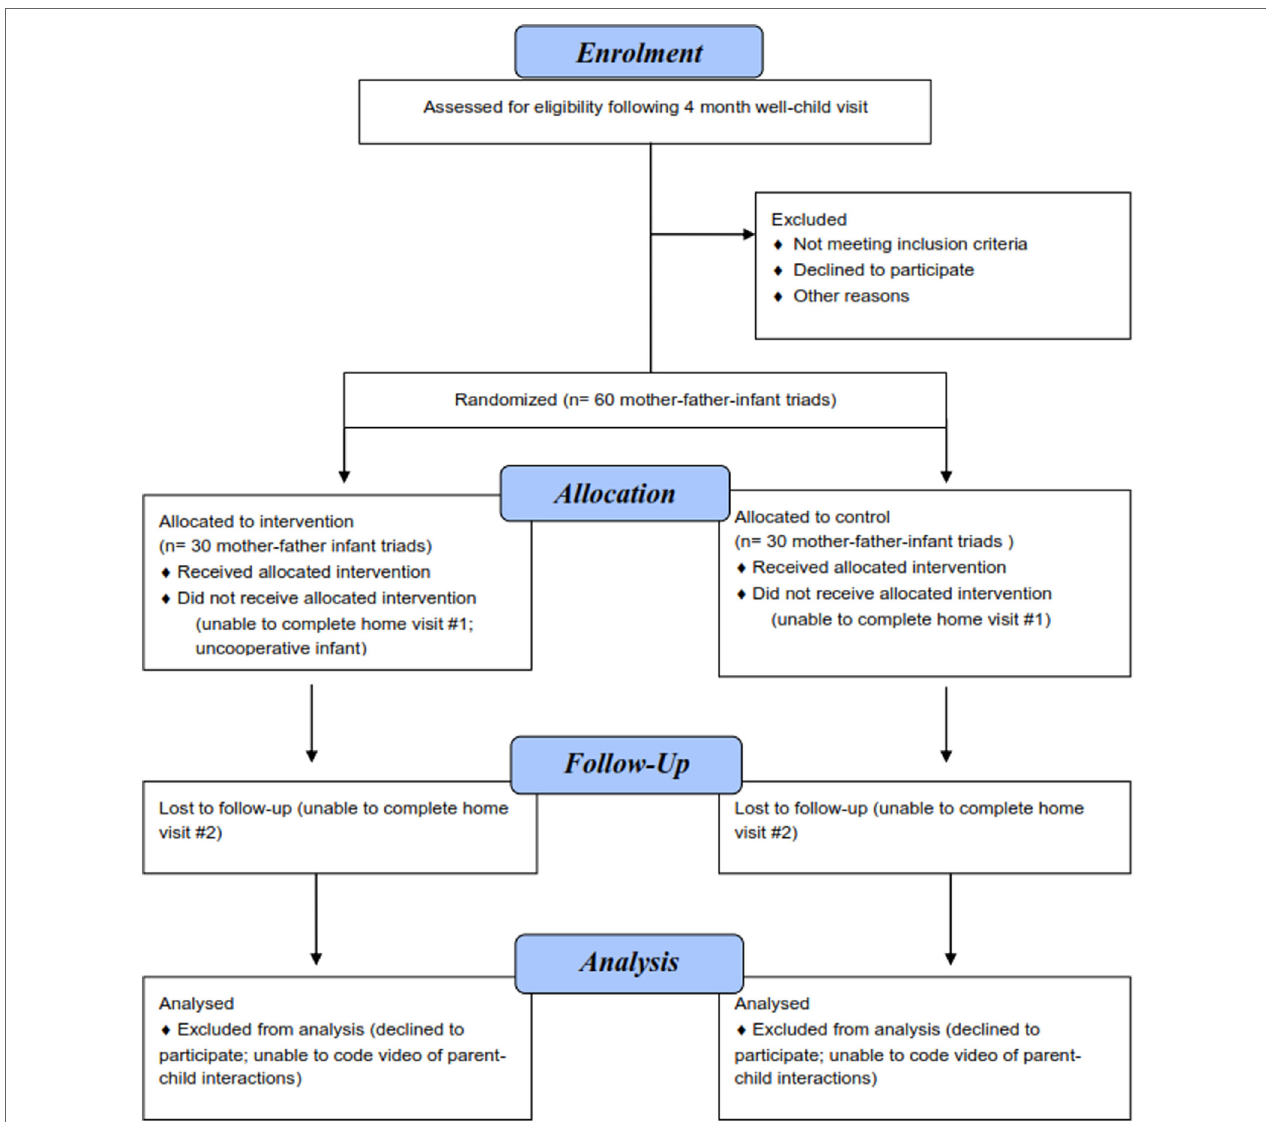
FigurE 3 | Proposed Consolidated Standards of Reporting Trials (CONSORT) flow